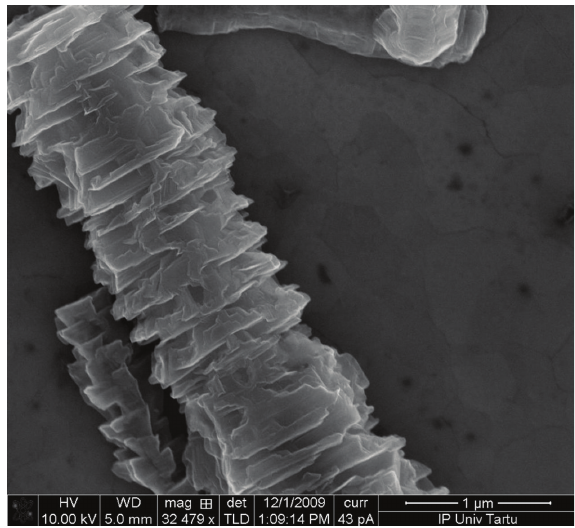
electrochemical reduction of H 2 O 2 are visible at the peak potential − 1.37 V versus Ag/AgCl (3 M NaCl) at a